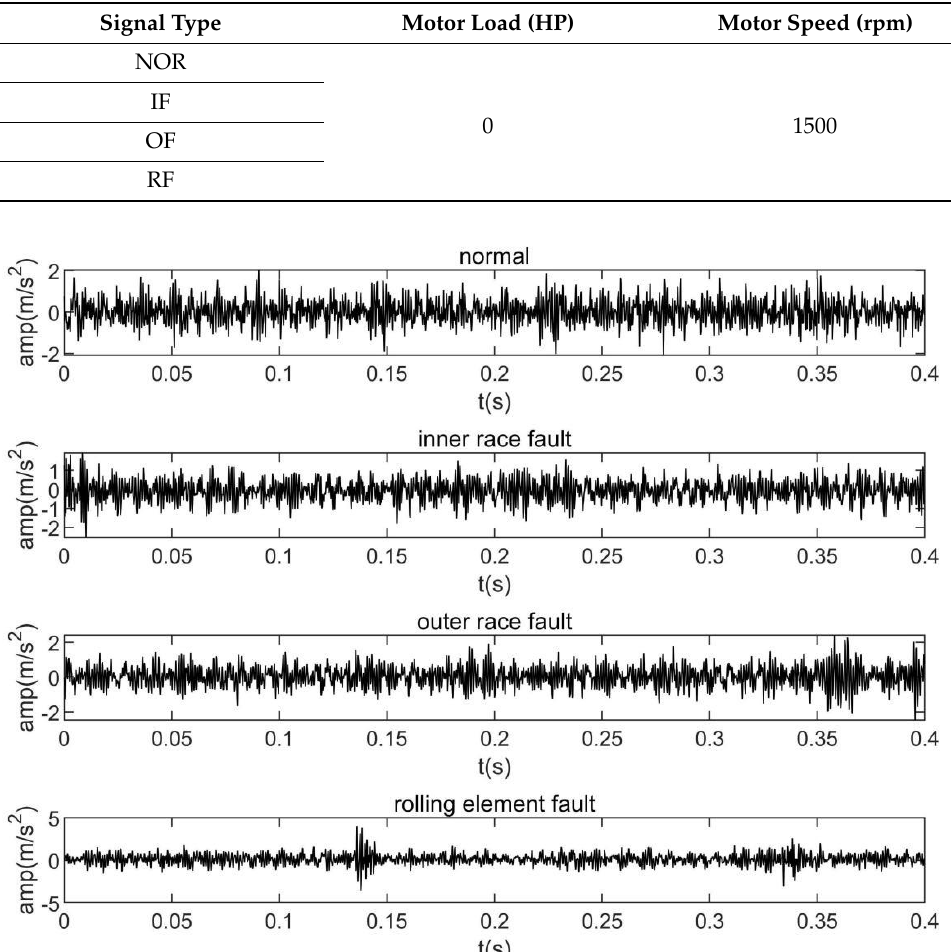
Figure 5. The time domain wave forms of original signals under four bearing states. Table 1. Signal Data Type Description.